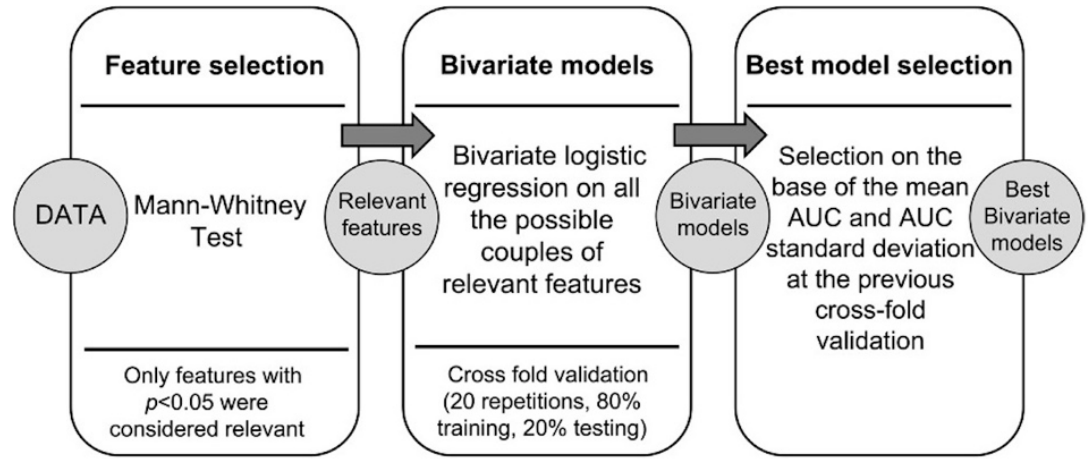
Figure 2. Radiomics computational pipeline.